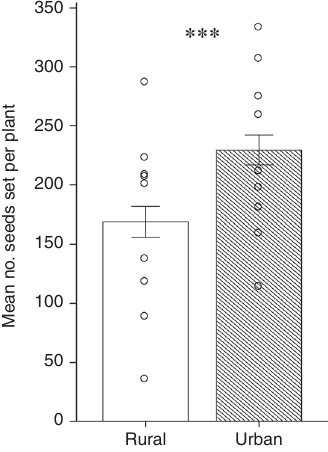
Fig. 4 Trifolium pratense seed set in fl ower-rich rural versus paired fl ower-rich urban sites. Mean number of T. pratense seeds set per plant ( N = 7 in fl orescences per plant, N = 10 plants per site) in N = 9 fl ower-rich rural versus N = 9 paired fl ower-rich urban sites; means± SE are shown; LMM: three stars, P < 0.001.